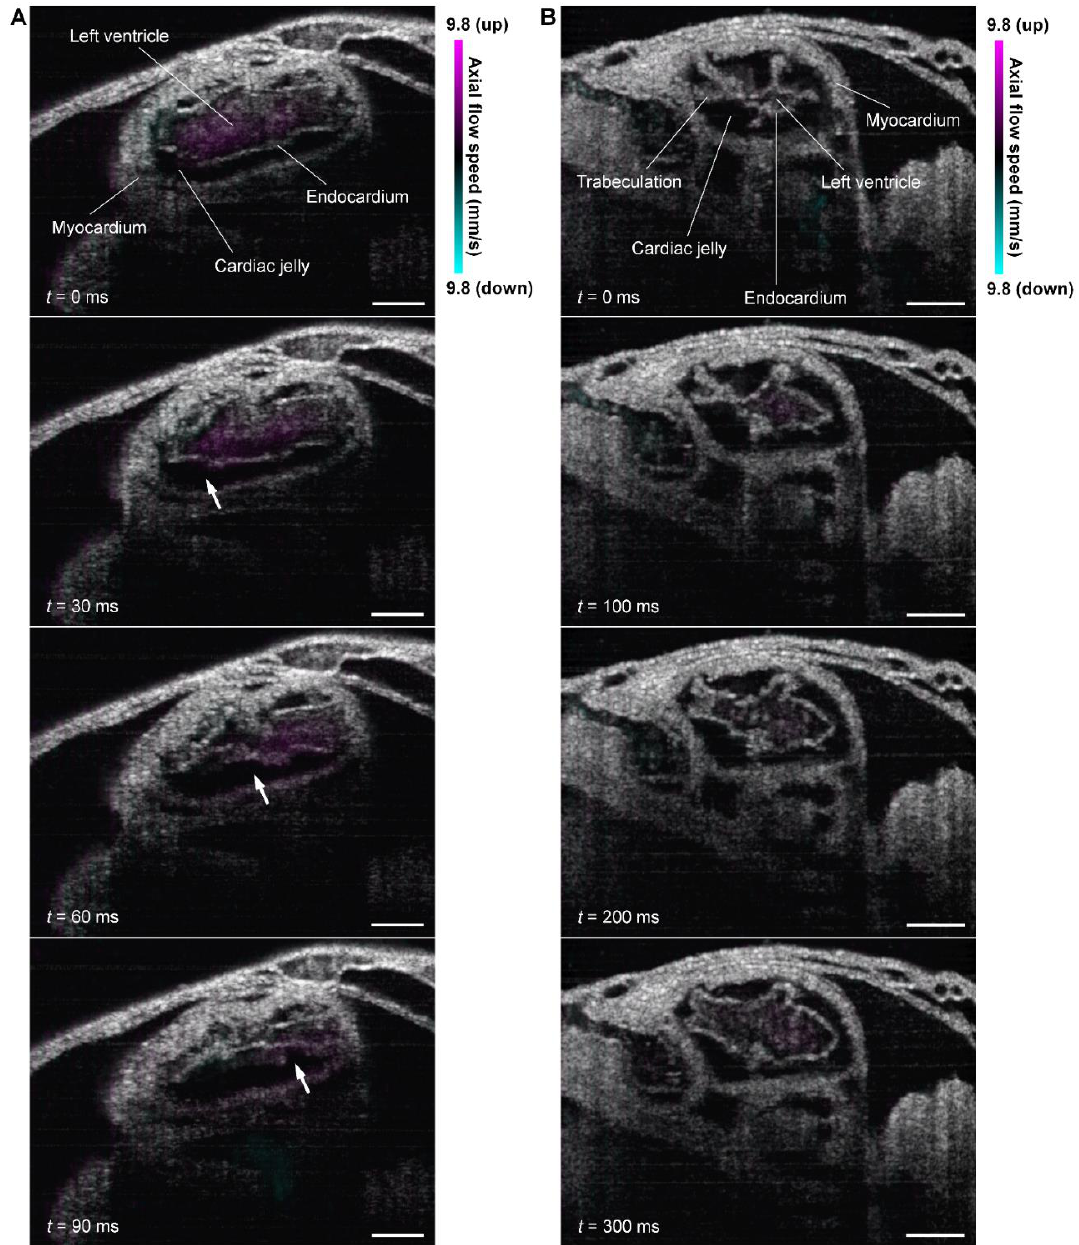
Figure 2. Four-dimensional OCT structural and Doppler imaging of the beating embryonic heart in the live mouse embryos at embryonic day 9.25 with cross-sectional visualizations. ( A ) Cardiac contraction wave in the left ventricle with the wave front (arrows) moving from left to right. ( B ) Left ventricular expansion with blood filling into the left ventricle. Scale bars are 100 µm.